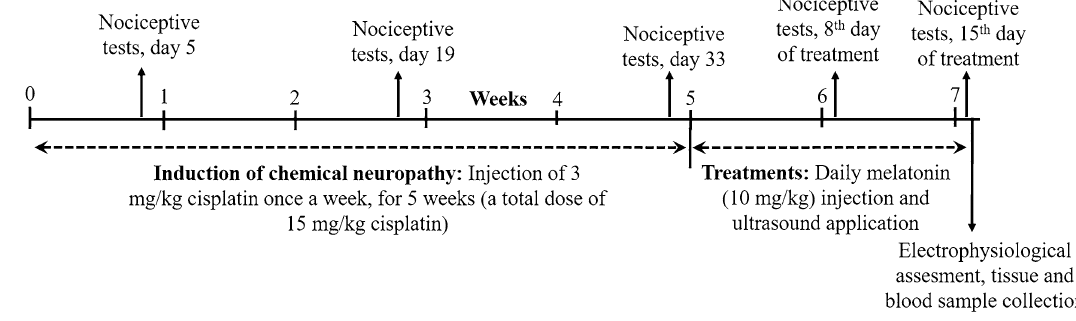
Figure 1. Schematic diagram demonstrating the timing of experimental procedures applied on rats.